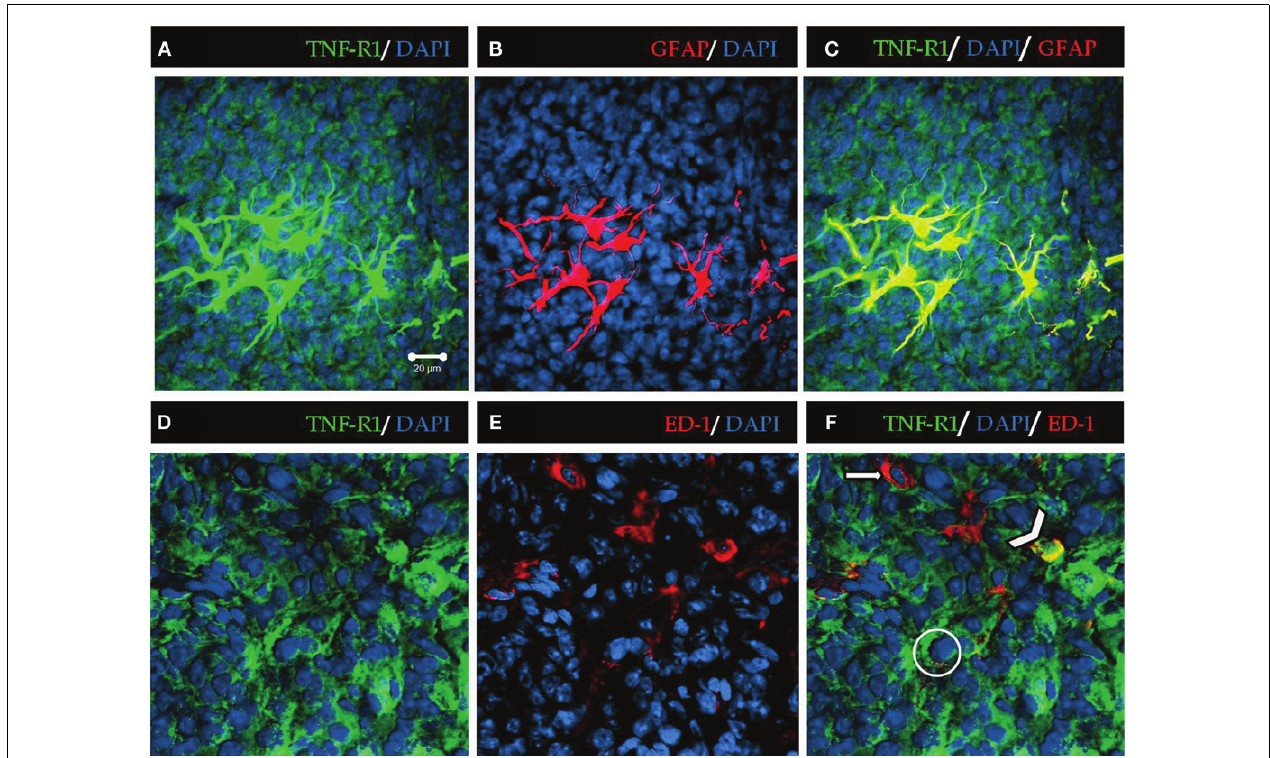
represents nuclei stained by DAPI.The yellow merged images show positive co-localization ofTNF-R1 in astrocytes (C) and microglia (F) .The filled arrow (F) indicates that microglia (red) are negative forTNF-R1, and the arrowhead shows positive co-localization between microglia andTNF-R1 (yellow).The circle shows a pinealocyte expressingTNF-R1 (green). Scale bar = 20 μ